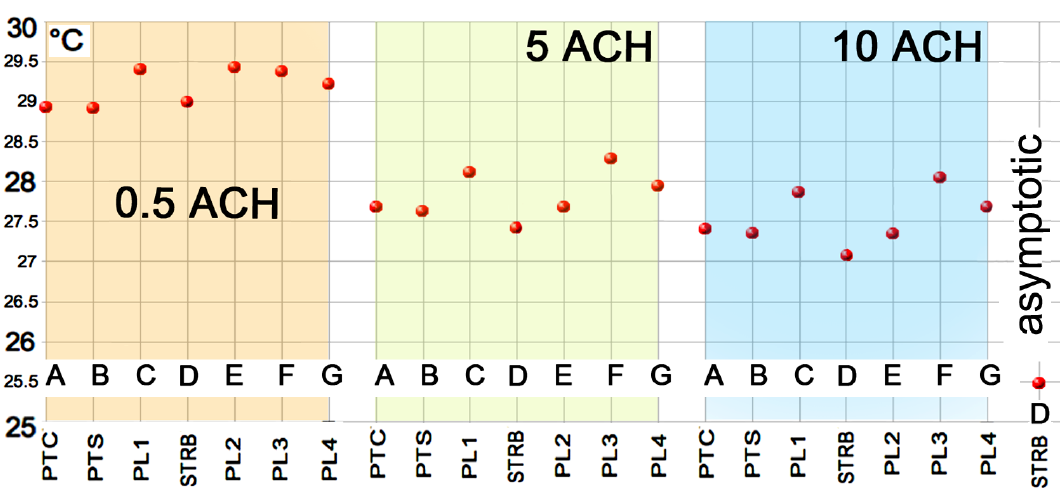
Figure 11. Maximum zone operative Tin free-floating mode at different ACH (17